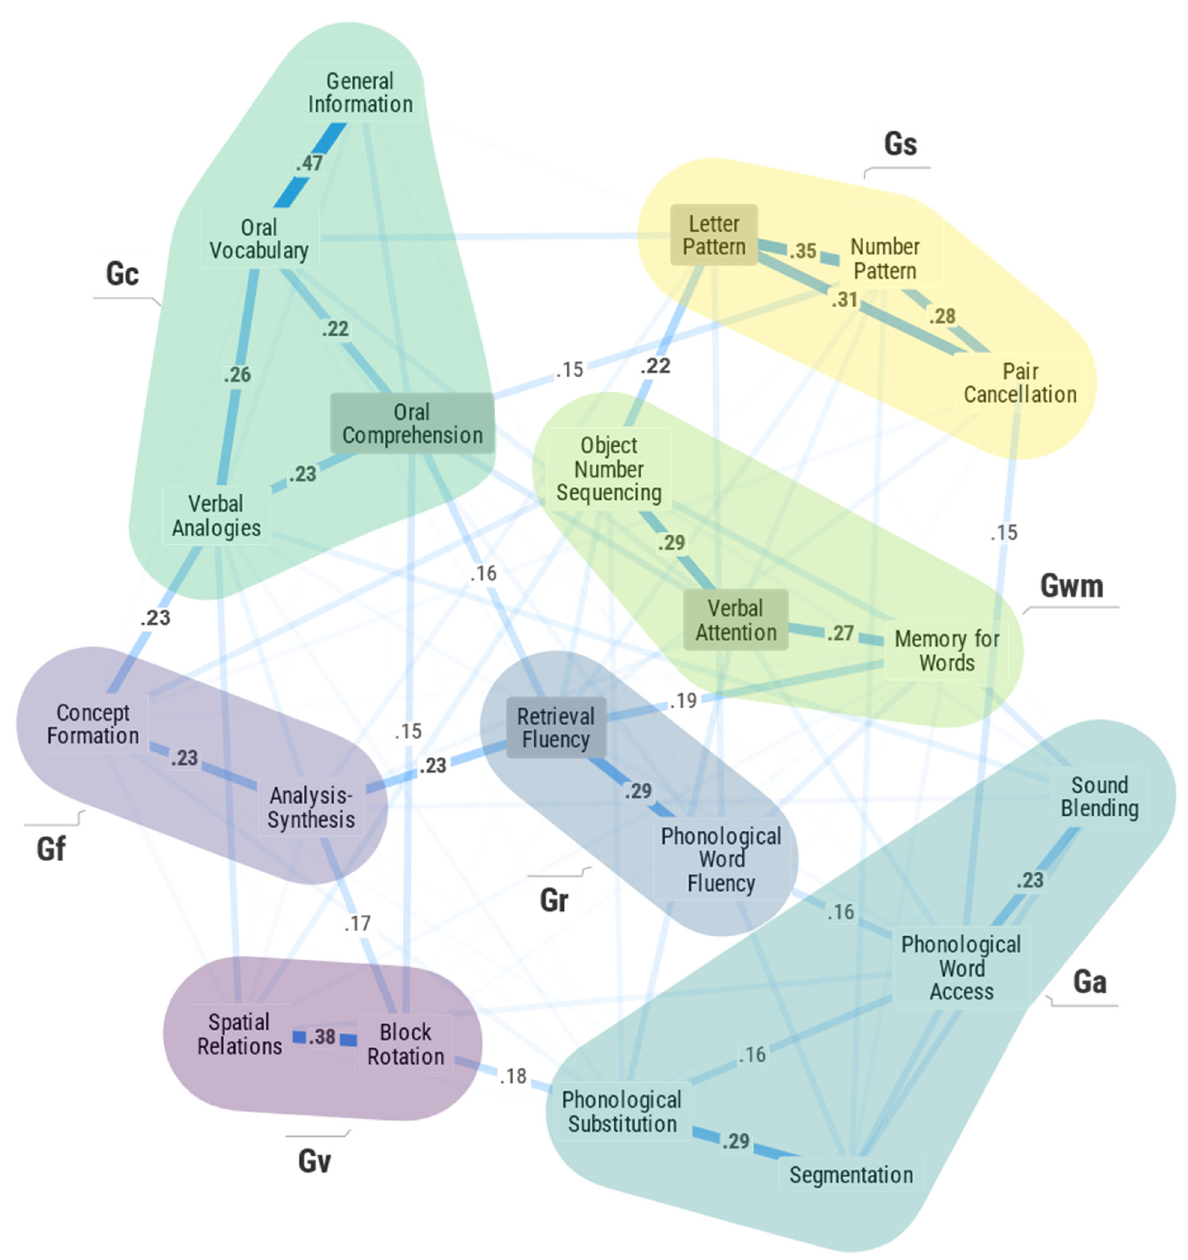
Figure 1. Weighted undirected network structure of 20 select WJ IV measures of seven broad CHC abilities in the primary network model. Note. Numbers are the edge weights (thickest lines) greater than or equal to .15. Edge weights greater than or equal to .20 in bold font. The four most central nodes are enclosed in gray boxes (see manuscript text).